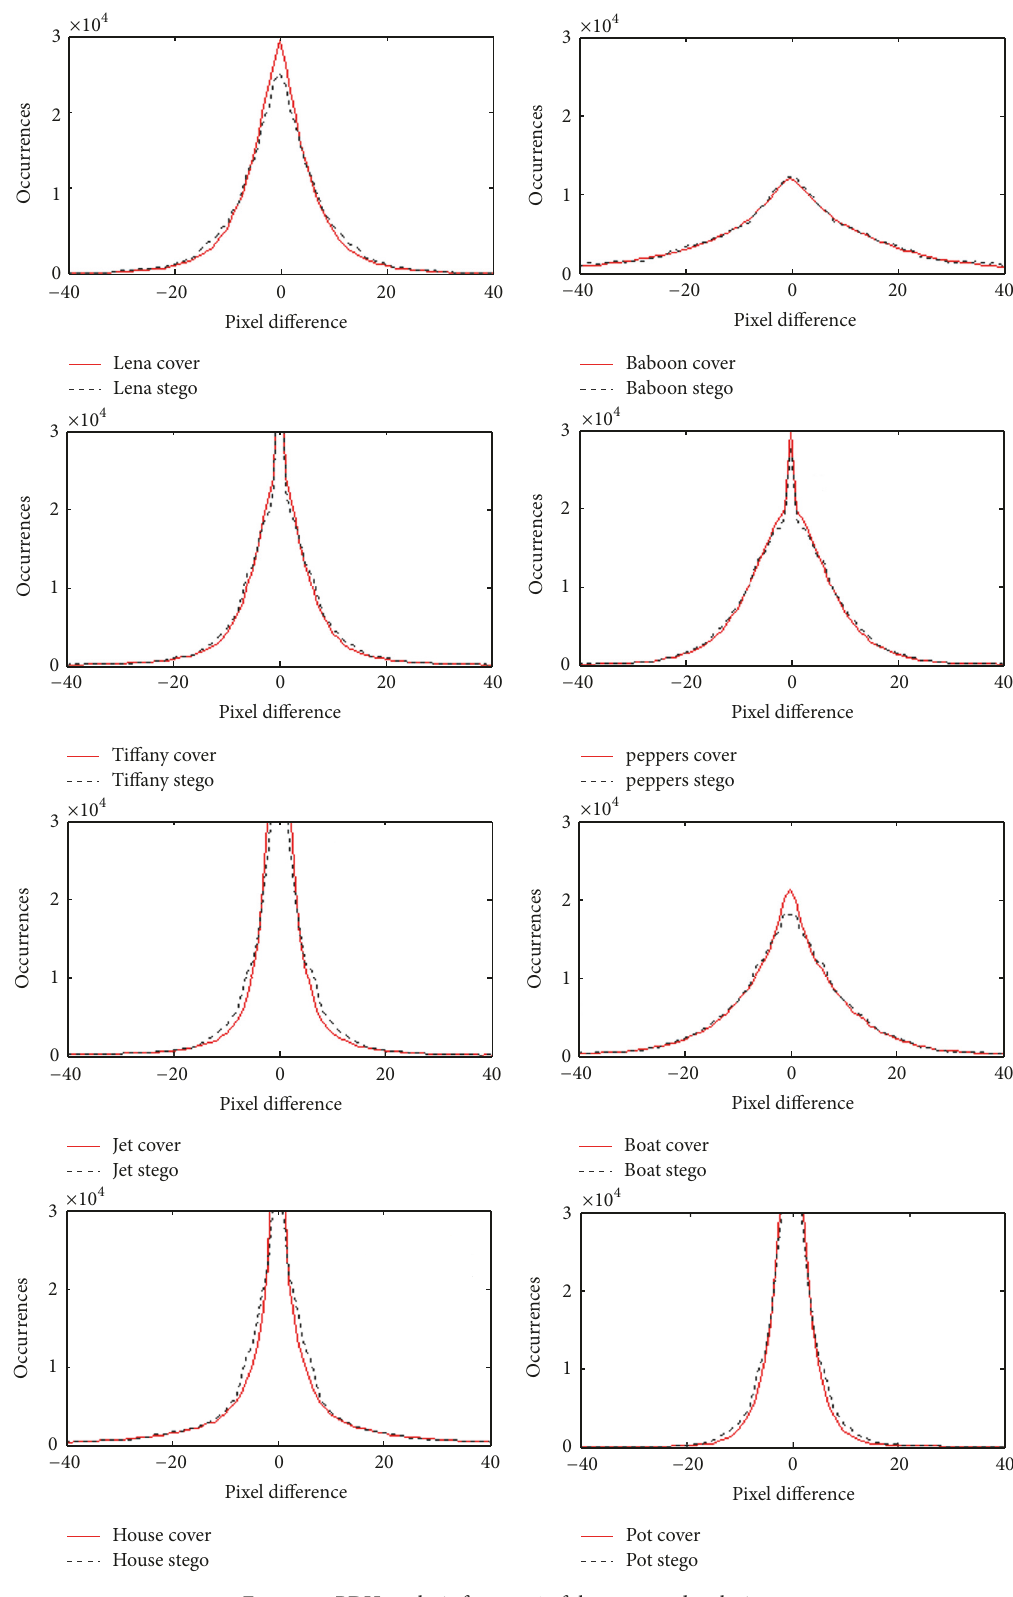
Figure 7: PDH analysis for type 1 of the proposed